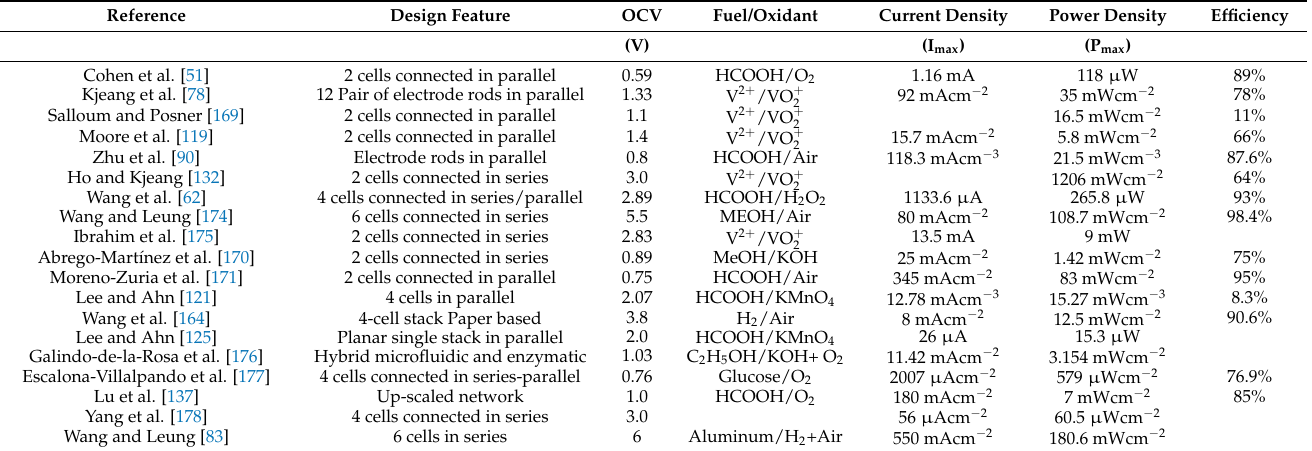
Table 2. Performance of stacked